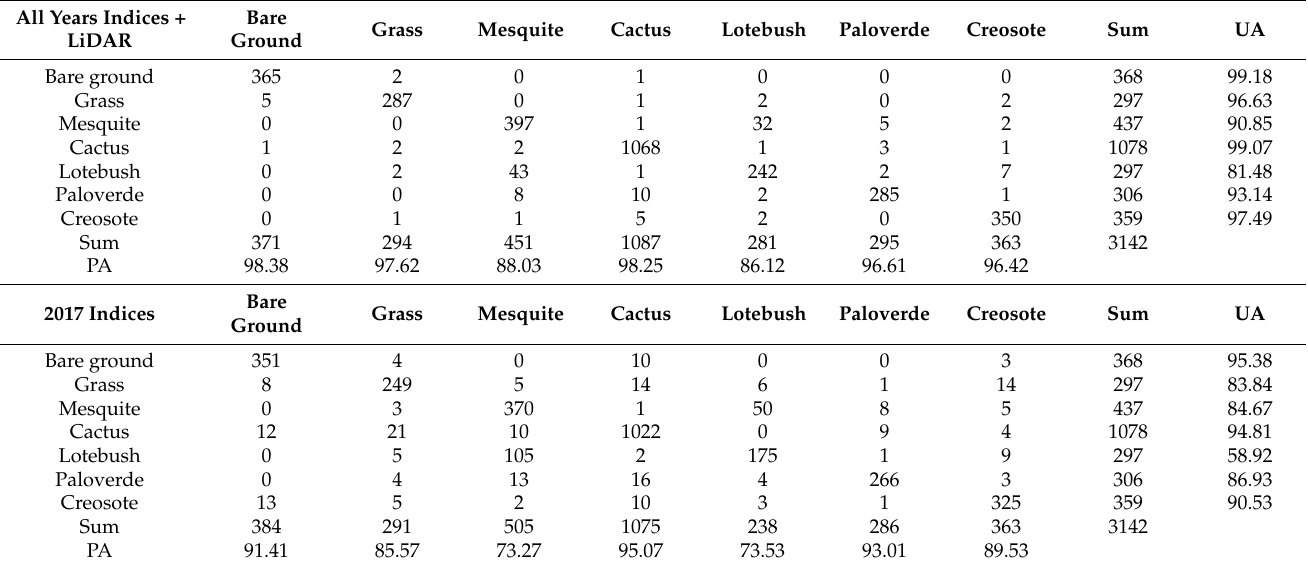
Table 4. Shows error matrix and producer/user accuracies for classification iteration with the highest overall accuracy (All Years Indices + LiDAR) and the lowest overall accuracy (2017 Indices).